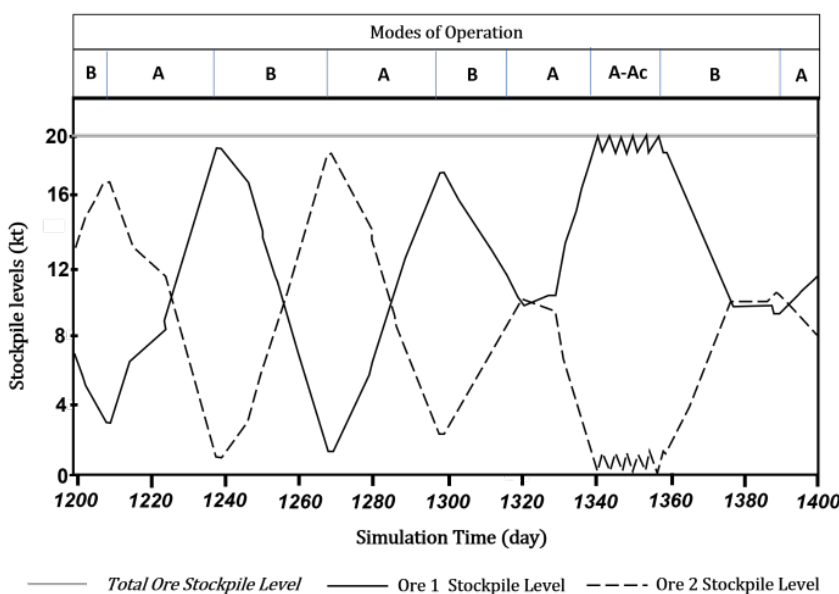
Figure 9. Stockpile levels of Ore 1 and Ore 2 over time during a simulation and the respective active operational mode, in which “A-Ac” denotes the alternation between the Regular and Contingency configurations of Mode A.